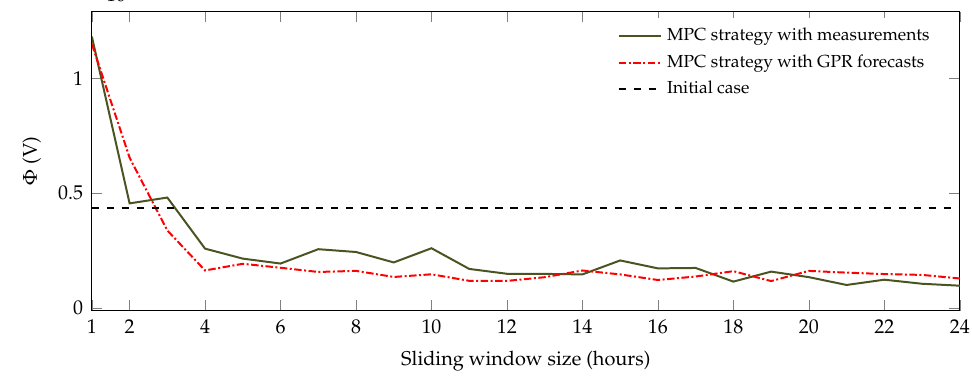
Figure 7. The total surface area of voltage overshooting per sliding window